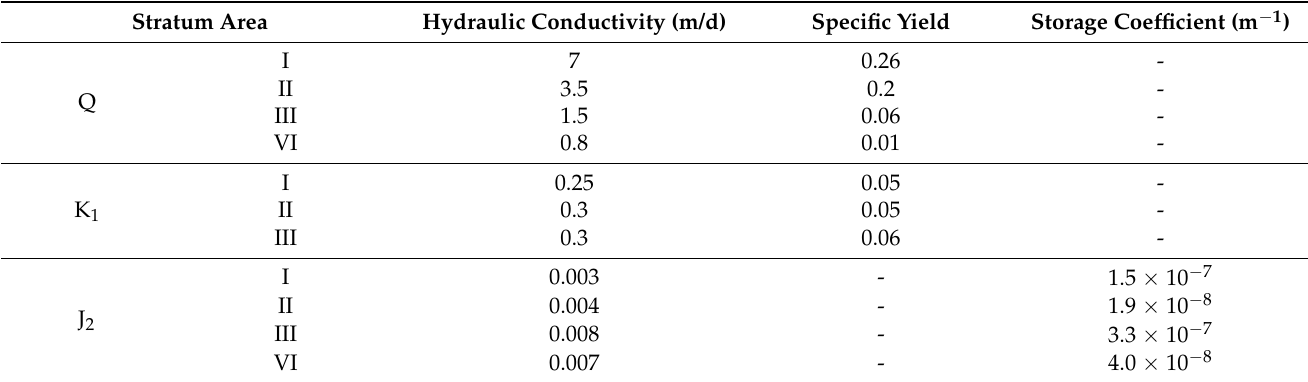
Table 2. Hydrogeological parameters of aquifers.